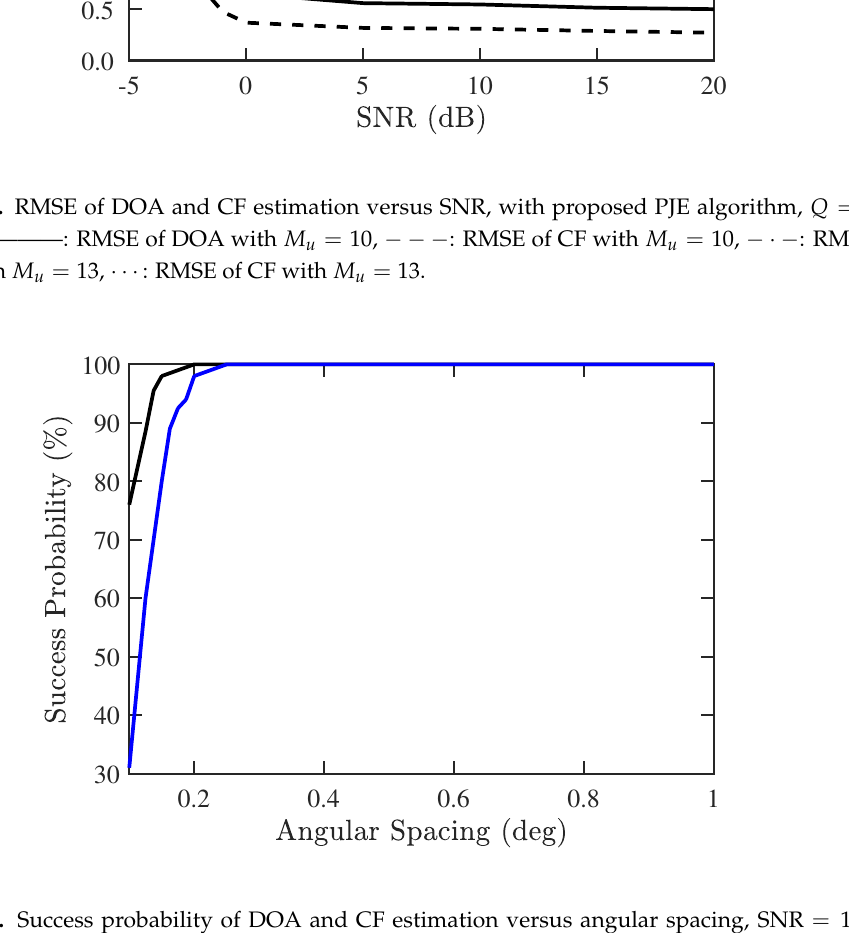
Figure 13. Success probability of DOA and CF estimation versus angular spacing, SNR = 10 dB, Q = 300, M = 3, M u = 1. ———: proposed PJE algorithm, ———: conventional JE